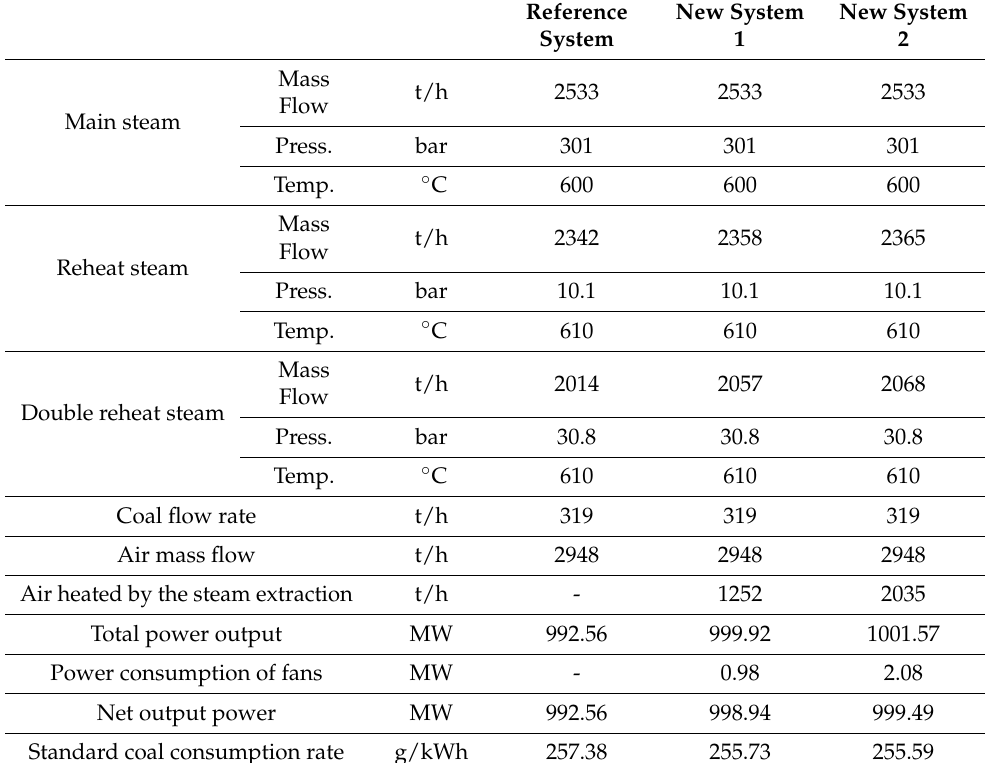
Table 2. Main performance data and calculation results of three